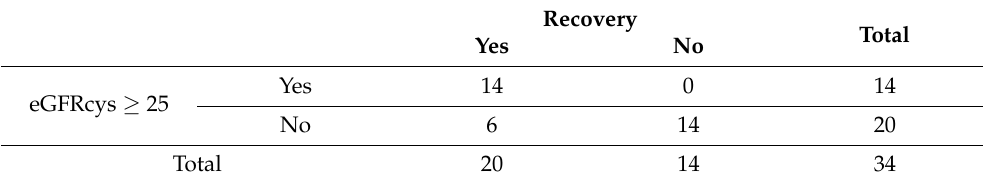
Table 4. Crosstabulation table between eGFRcys ≥ 25 and recovery from severe eGFRcreat depression a .